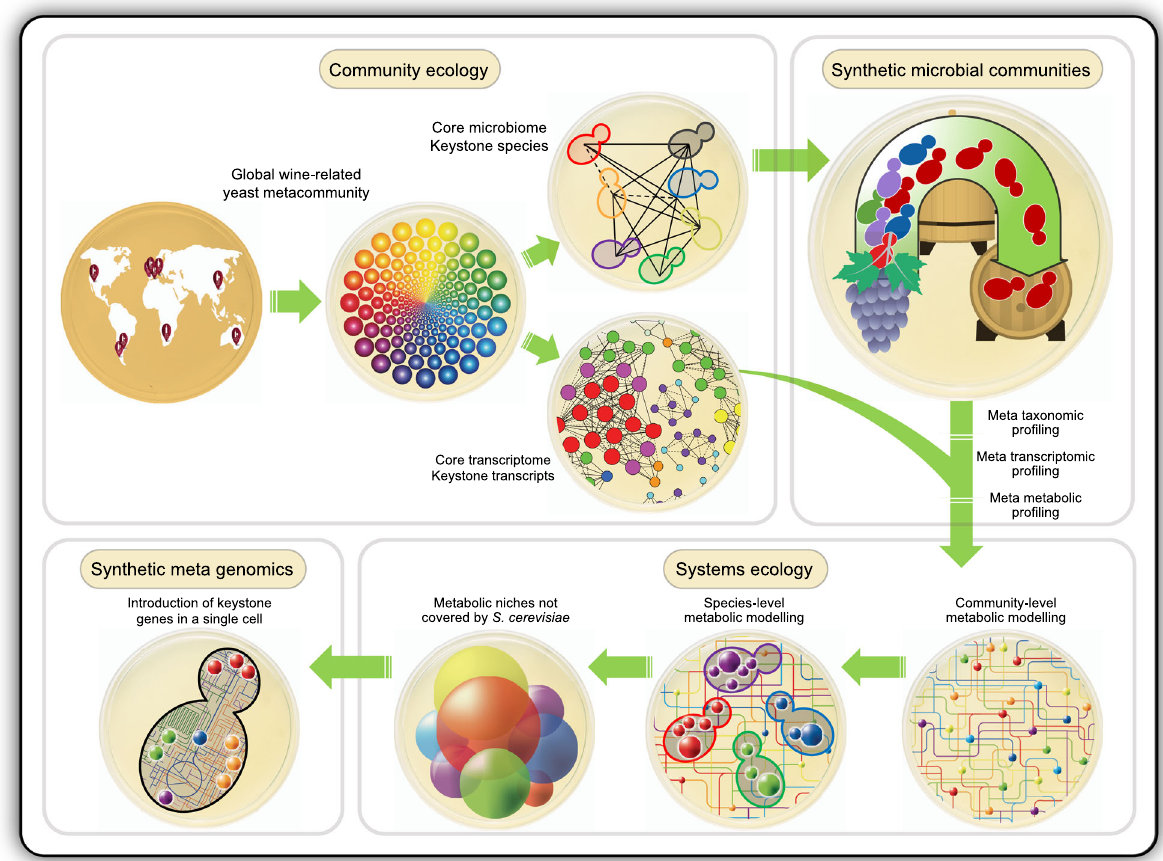
Fig. 1 The idea of encapsulating the complexity of a natural yeast community with a representative synthetic metagenome. This concept explores the potential to reproduce a whole ecosystem ’ s metabolic network in a single yeast